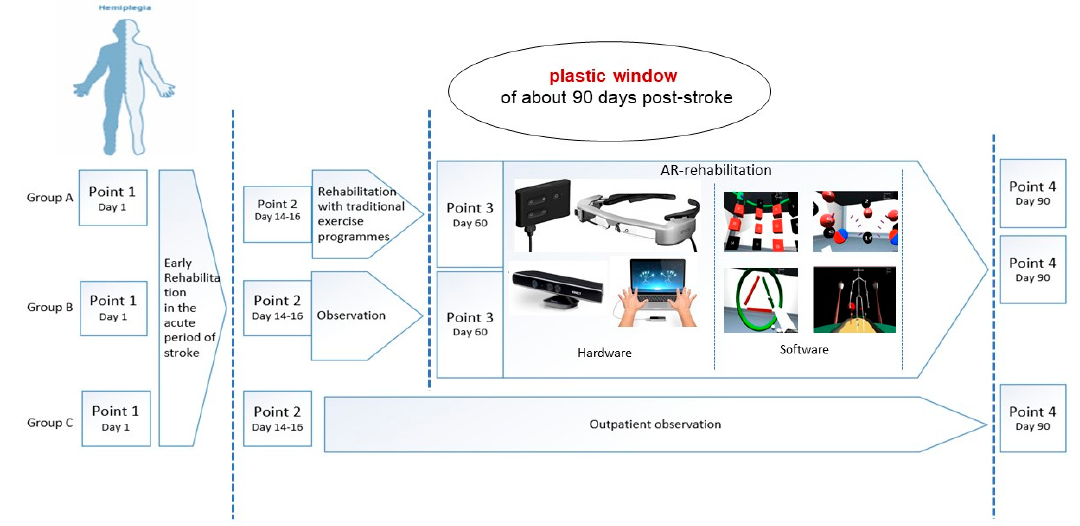
Figure A1. Study design.